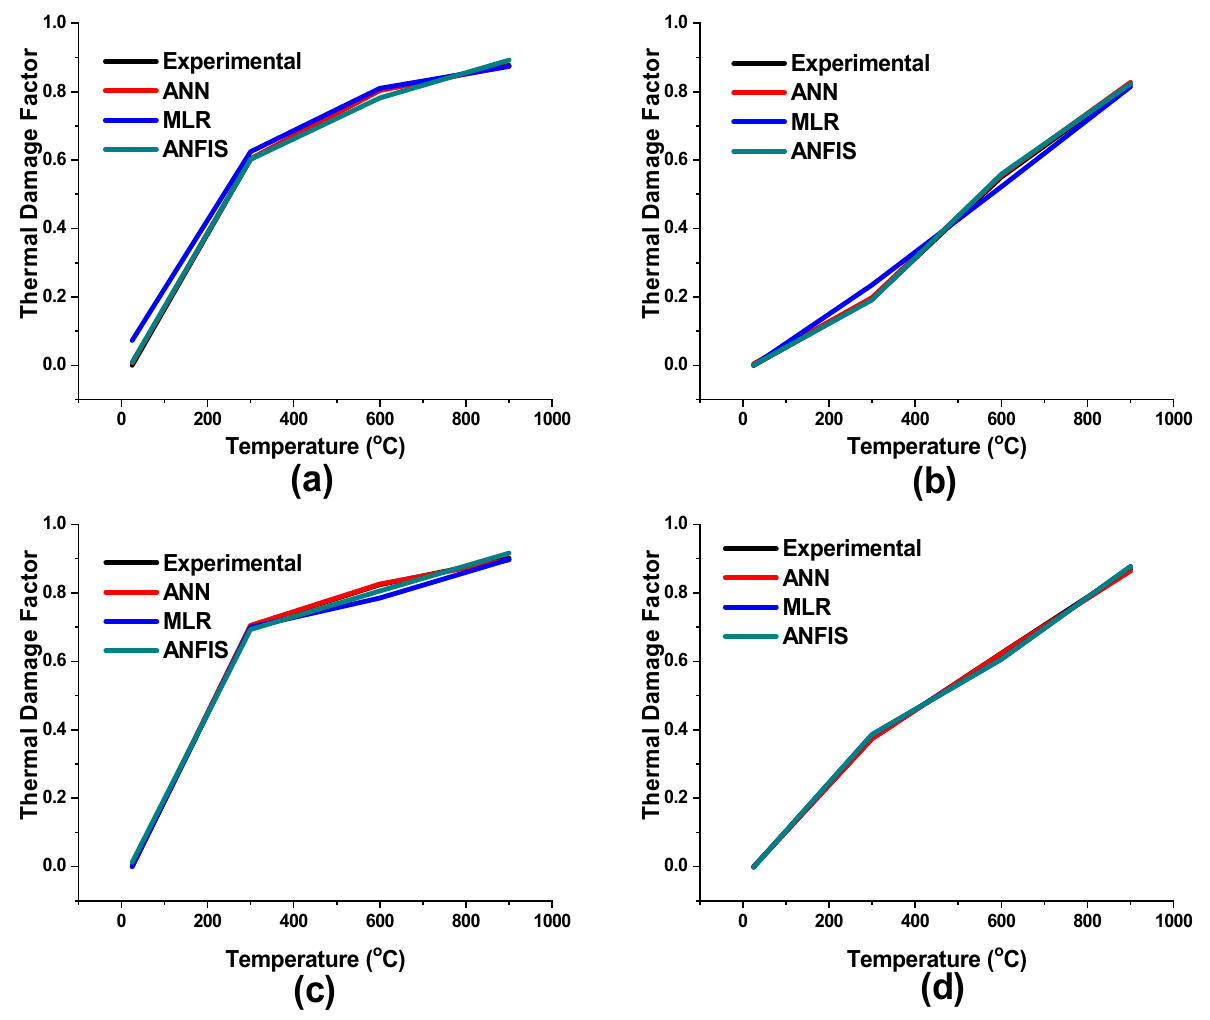
Figure 12. Experimental ANN, MLR, and ANFIS models; ( a ) porosity-based D T under slow cooling, ( b ) elasticity-based D T under slow cooling, ( c ) porosity-based D T under rapid cooling, and ( d ) elasticity-based D T under rapid cooling.